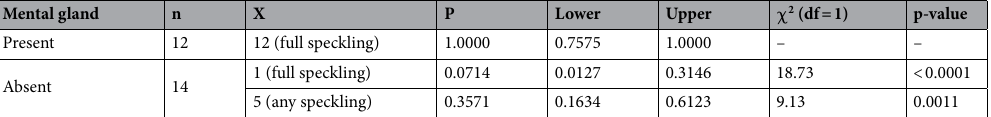
Table 1. Point estimates and 95% confidence intervals (using the Wilson method) for the prevalence of biofluorescent speckling in presumed male and female Plethodon metcalfi .